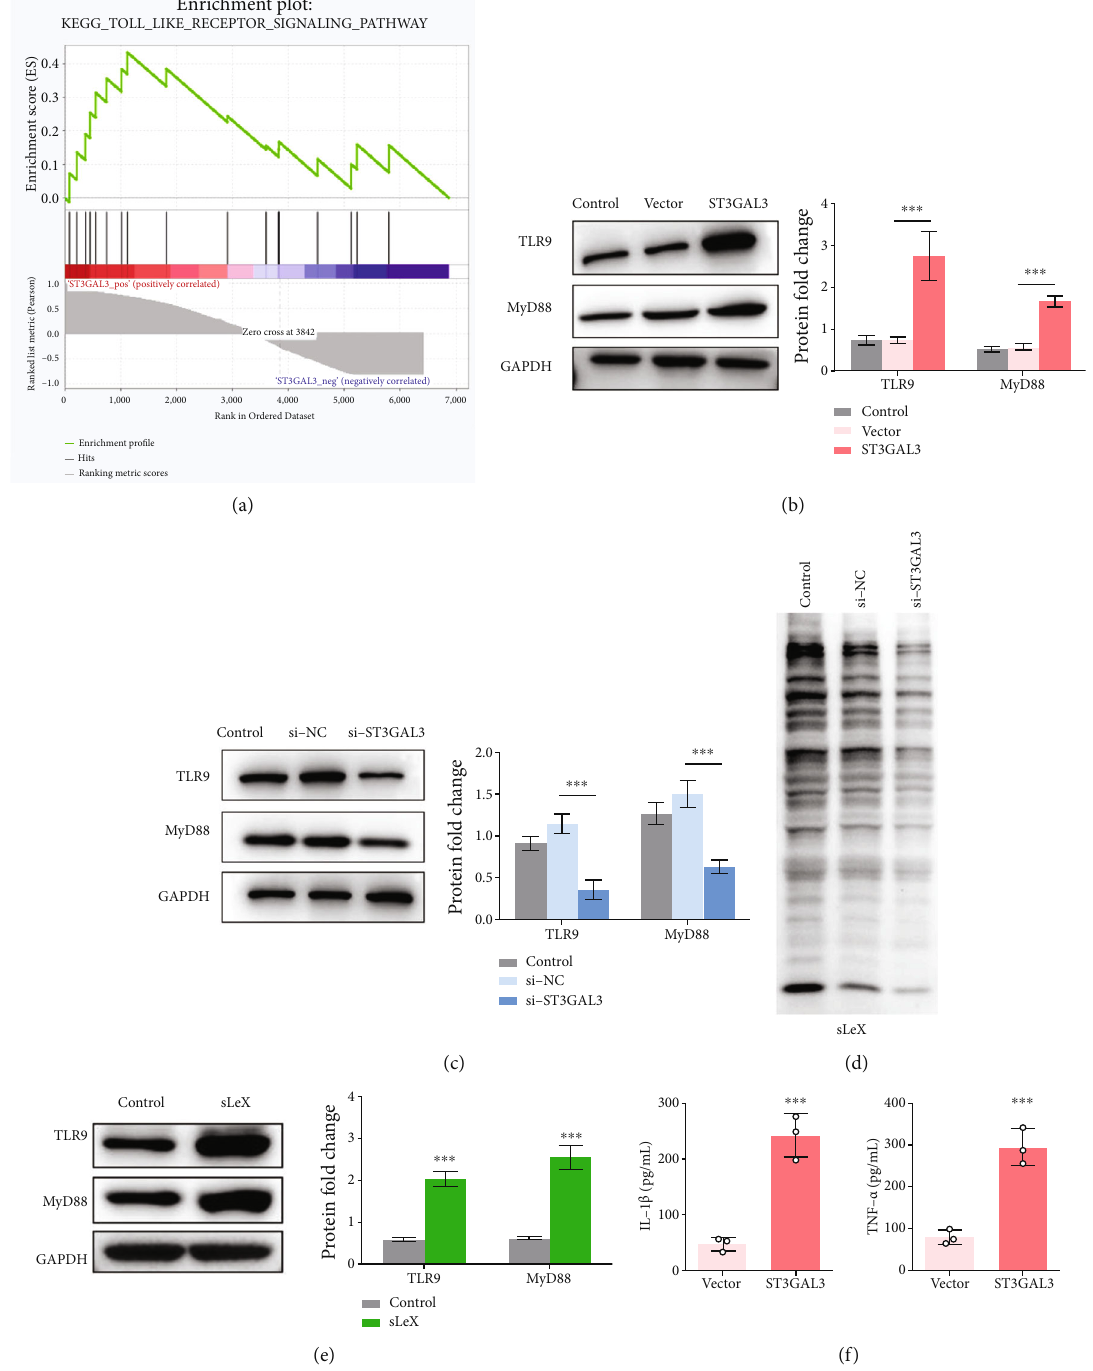
Figure 5: ST3GAL3 regulated the TLR9/MyD88 signalling pathway. (a) GSEA software was used to analyse the enrichment signalling pathways associated with ST3GAL3 in RA. TLR signalling pathway was fi nally screened out. (b) Western blotting results showed that ST3GAL3 overexpression promoted the expression of TLR9 and MyD88. (c) Western blotting results showed that si-ST3GAL3 inhibited the expression of TLR9 and MyD88. (d) Western blotting result showed that si-ST3GAL3 inhibited sLeX levels in MH7A cells. (e) Western blotting result showed the activated TLR9/MyD88 signalling pathway by adding with sLeX in MH7A cells. (f) ELISA results showed that ST3GAL3 overexpression increased IL-1 β and TNF- α levels. n = 3 . ∗∗∗ p < 0 : 001 compared with the indicated